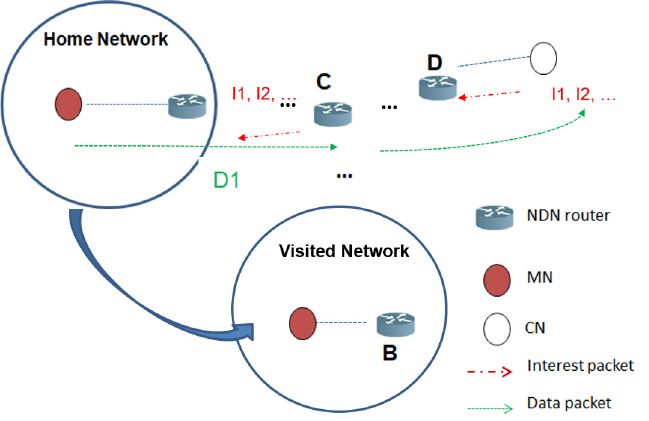
Figure 4. Producer mobility example. The MN is a producer node on the move. Some data packets are sent before handing over. Once the MN attaches to the visited network, no data packets are sent, as the MN does not get Interest